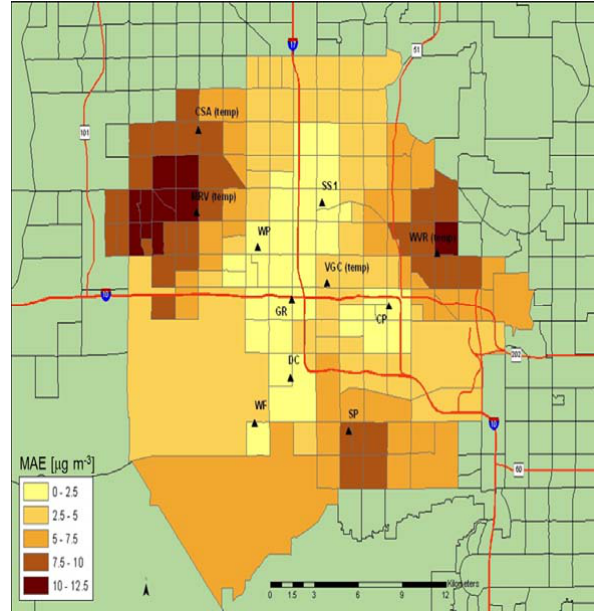
Fig. 4. Mean Absolute Error (µgm − 3 ) for December 2007 between IDW and OK methods – based on daily maps. (Abbreviations: